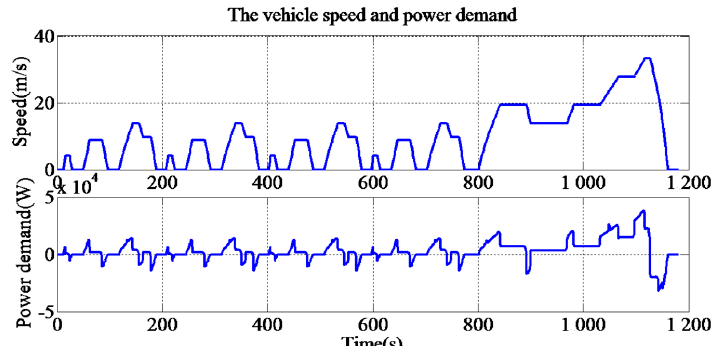
Figure 9. Speed and driveline power demand for the New European Driving Cycle (NEDC).